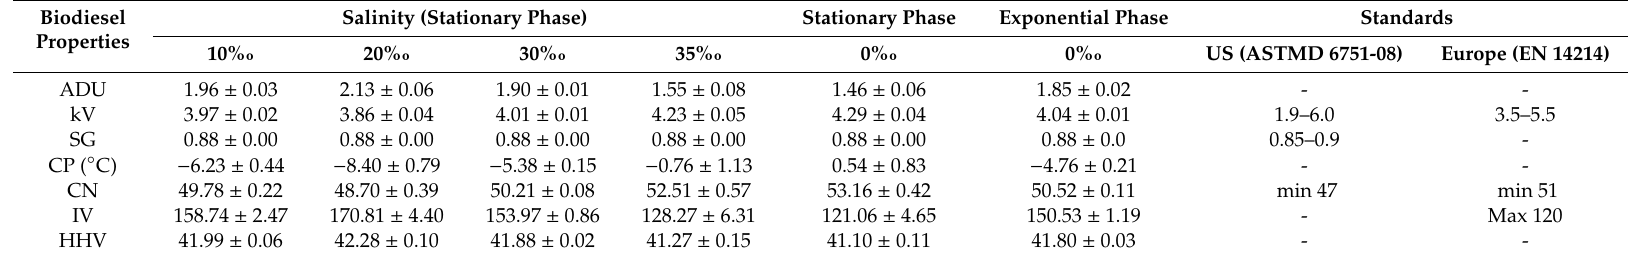
Table 7. Biodiesel properties of Desmodesmus sp. nl3 in di ff erent salinities and growth